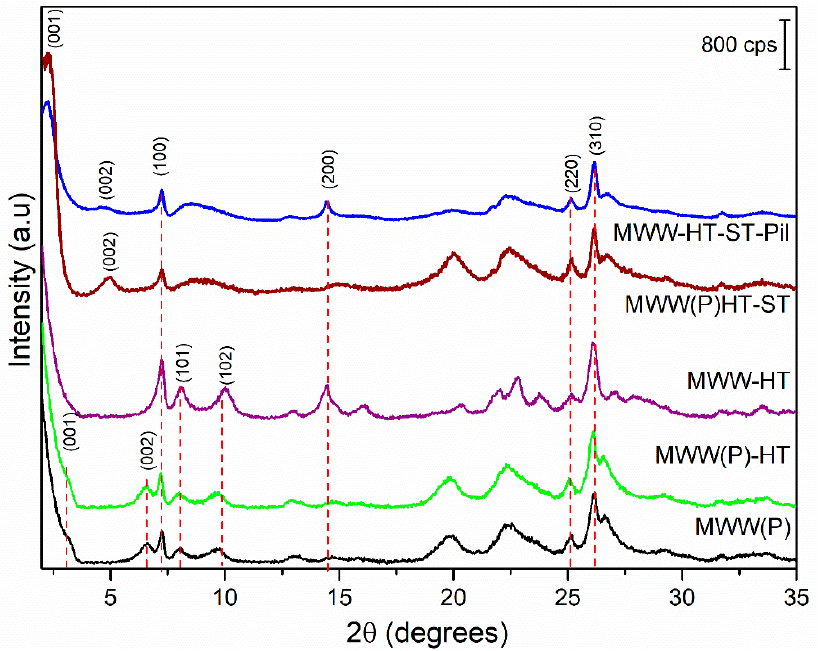
Figure 1. X-ray diffractograms of the MWW(P), MWW(P)-HT, MWW-HT, MWW(P)HT-ST and MWW-HT-ST-Pil zeolitic samples.